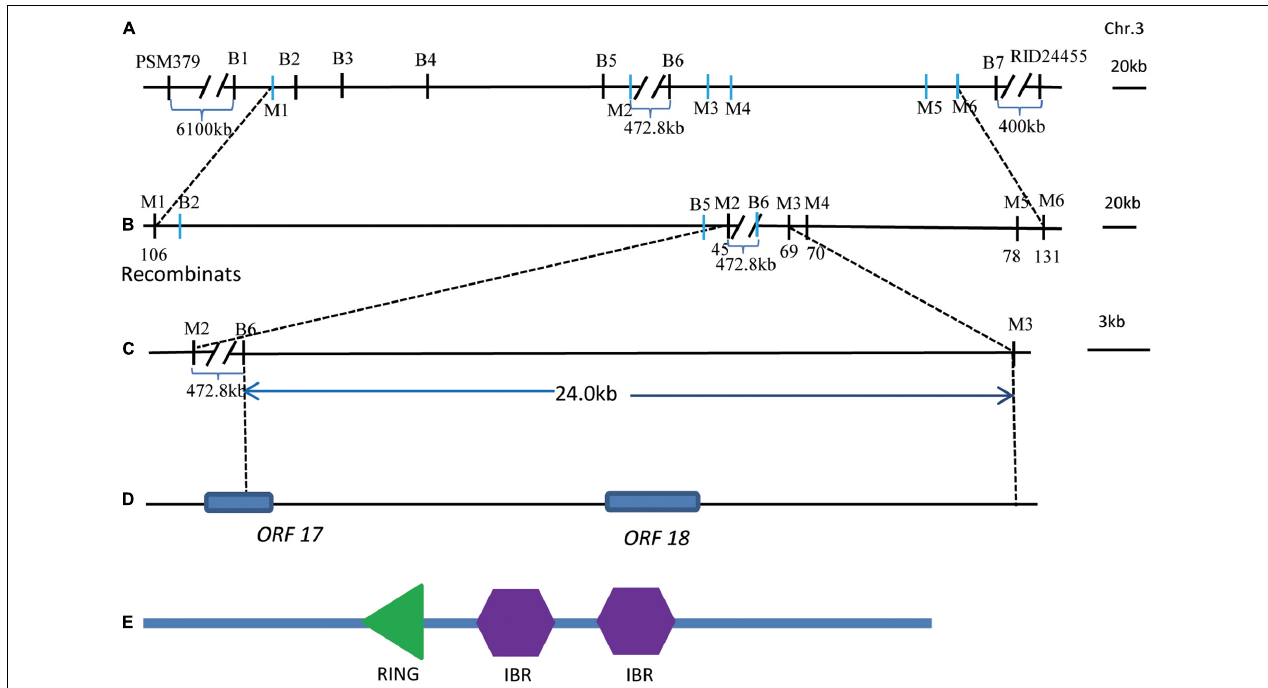
FIGURE 4 | Fine mapping of qGL3.5 . (A) Regions associated with GL identified via the ED method of BSA. B1 to B2 were the first region, B3 was the second association region, B4 to B5 was the third association region, and B6 to B7 was the fourth association region. (B) Genotype and phenotype analysis of the associated regions determined using newly developed Indel markers. M1–M6 were Indel markers. (C) qGL3.5 was mapped to the genomic interval between the flanking markers M2–M3. Because the region from B5 to B6 was not the associated regions, qGL3.5 was mapped to the genomic interval between B6 and M3, which was narrowed down to a 24.0-kb region. (D) There was only one complete annotated gene, ORF18 , and part of the coding region of another gene, ORF17 , with non-synonymous SNPs between KJ01 and Huaye 3 based on BSA-seq analysis. (E) Domains for the candidate ORF18